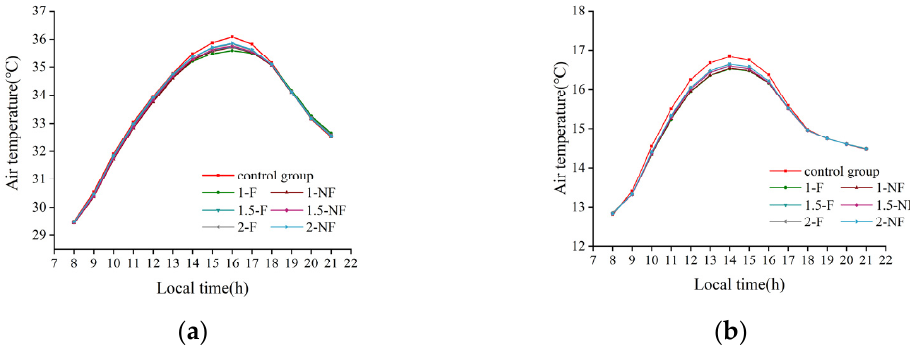
Figure 9. Effects of different arrangements of arbors on air temperature in summer ( a ) and winter ( b ).